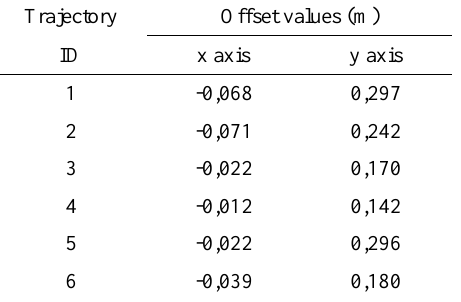
Table 3. Kinect generated trajectories starting points were always projected to 2D plane with an offset, compared to specified trajectories position.